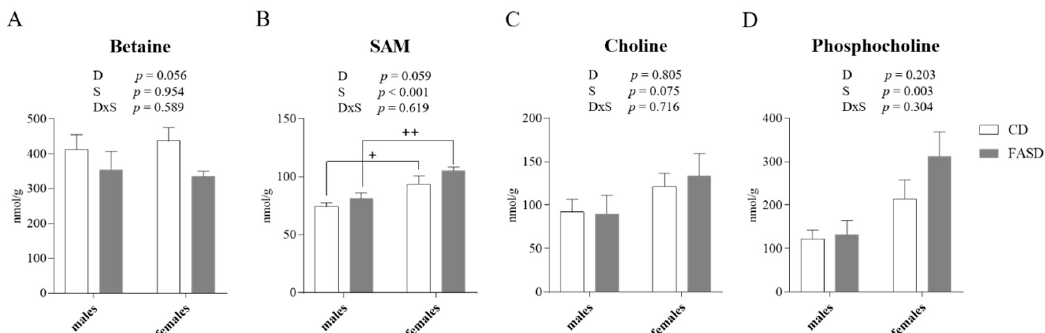
Figure 4. Concentrations of choline-derived metabolites measured by LC-MS in offspring liver. ( A ) FASD pups showed reduced betaine compared to CD pups. ( B ) FASD pups showed increased SAM compared to CD pups, and male pups showed reduced SAM compared to females. ( C ) Male pups showed reduced choline compared to females. ( D ) Male pups showed reduced PCho compared to females. n = 7–8 / group. White bars: CD animals, gray bars: FASD animals. Values represent means ± SEM. p values from 2-factor ANOVA are indicated at the top of each graph, and Tukey post-hoc significant p values are indicated as + p < 0.05, ++ p < 0.01. CD: Control diet, FASD: Folic